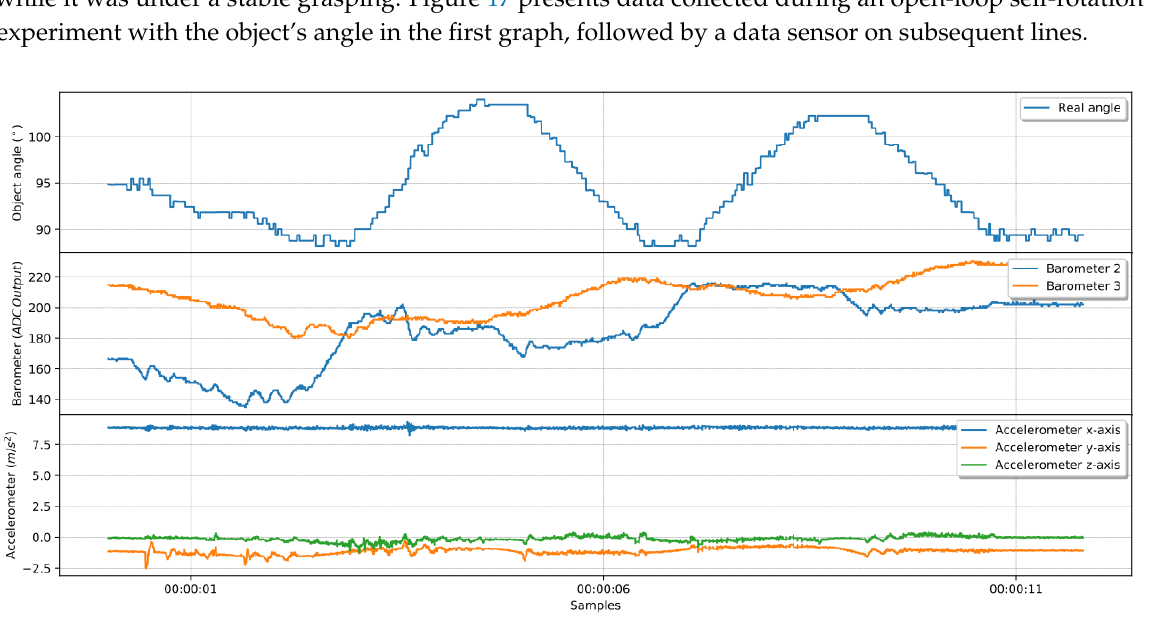
Figure 17. Object being rotated with sensors varying in accordance with the